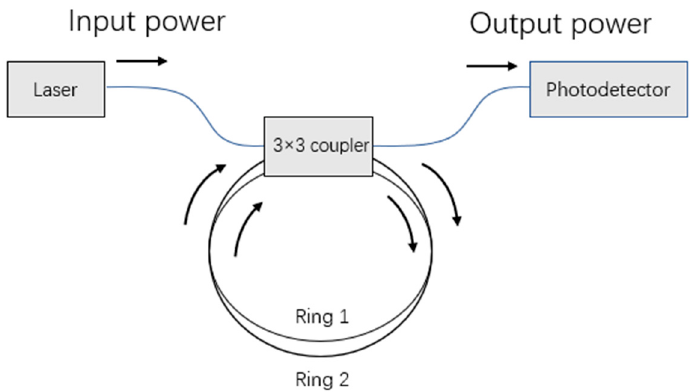
Figure 6. Double-ring resonator using a 3 × 3 coupler.